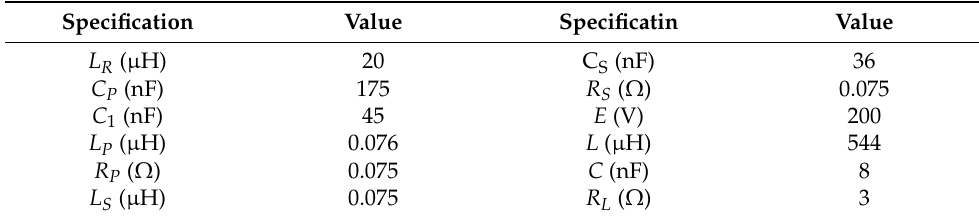
Table 1. Non-contact excitation motor